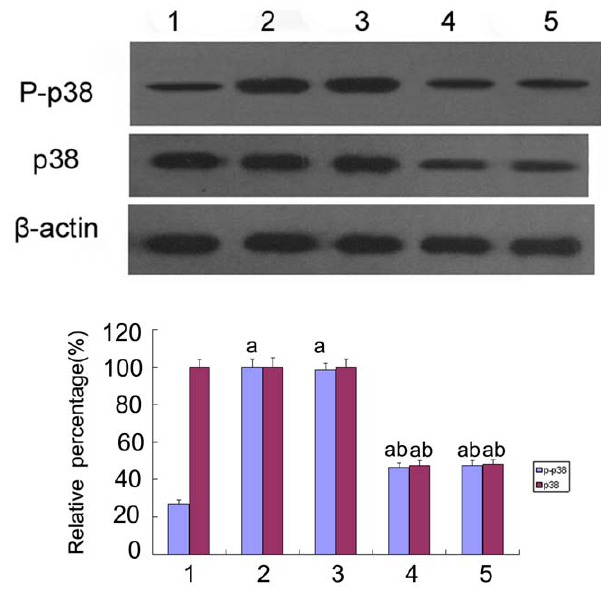
Figure 7. The expression of p38 MAPK and phosphorylated P38 MAPK by Western blot analysis. p38 MAPK and phosphory- lated p38 MAPK were measured by Western blot of the HK-2 cells cultured in 5.5 mM glucose (lane 1), 30 mM glucose (lane 2), 30 mM glucose + Cont siRNA(lane 3), 30 mM glucose + p38 siRNA for 24 h(lane 4), 30 mM glucose + p38 siRNA for 48 h(lane 5). Values represent the mean 6 SD, a P , 0.05 vs. 5.5 mM glucose, b P , 0.05 vs. 30 mM glucose.